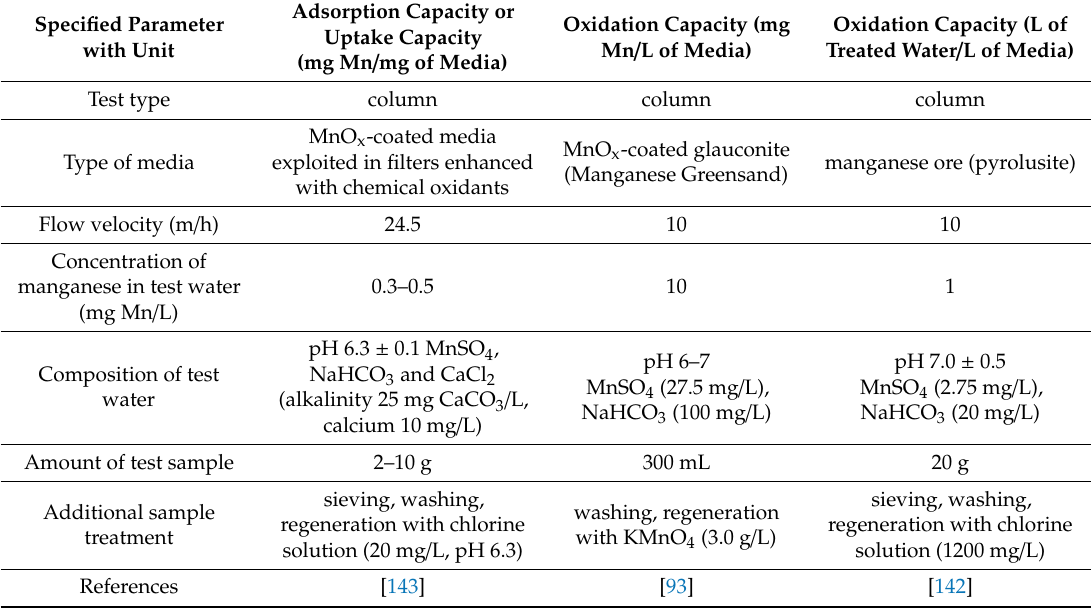
Table 3. Experimental procedures for comparing manganese removal ability of MnO x filter